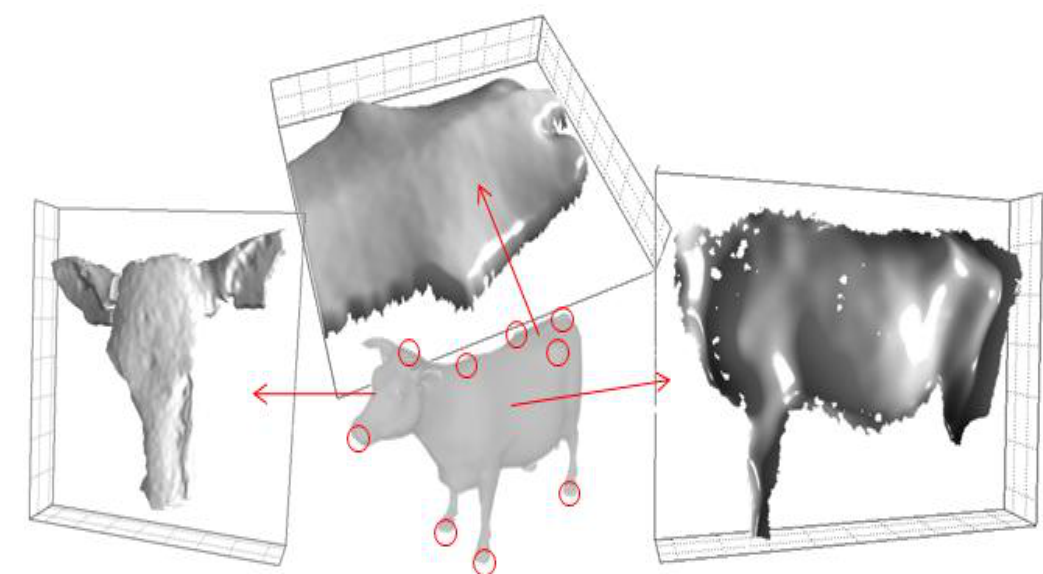
Figure 2. The system was implemented in order to allow for a fast extraction and monitoring of different body parameters, and in particular, hip and withers height, back slope, depth, hip distance, head size, and chest girth. Relevant points positions are indicated by red circles. Table 3. Dairy cattles